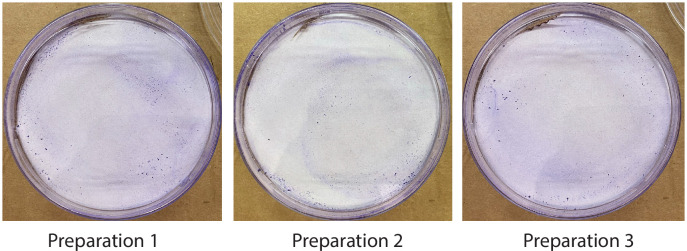
Verification of surviving mitochondrial donor cells following mitochondrial isolation.Images of three crystal violet stained 10 cm plates seeded with isolated mitochondria from ~1.5 × 10⁷ HEK293T dsRed donor cells taken from three independent mitochondrial isolations following dialyzed medium selection. Pictures were taken on a circular white disk matted within a cardboard frame for clarity.